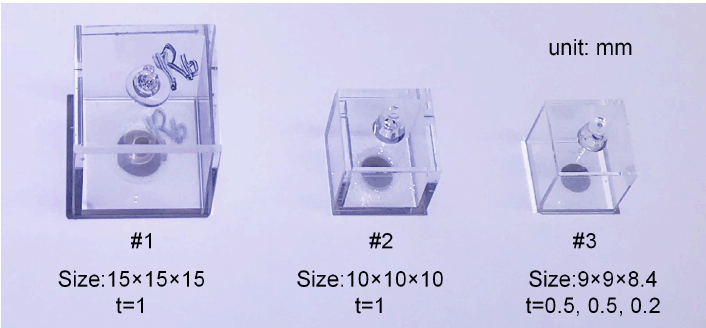
Figure 5. Photo of cuboidal vapor cells used in the experiments.